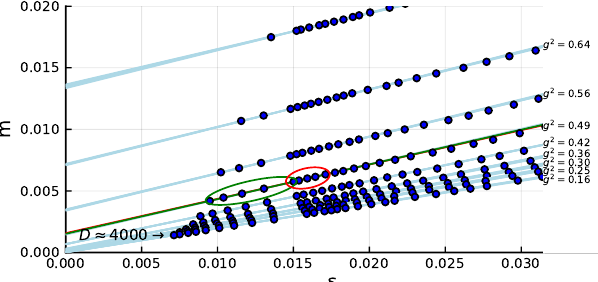
Figure 3 . Extrapolation of the inverse correlation length of the mixed transfer matrix (topological sector), corresponding to the mass estimator m K, 3 , as a function of δ , the spacing in the logarithmic spectrum of the transfer matrix [96]. For every value of the coupling g 2 we show a handful of linear extrapolations towards δ = 0 each taking different points into consideration. For example at g 2 = 0 . 56 we have highlighted the 5 points with highest bond dimension and the corresponding extrapolation in green. Another extrapolation where we discarded the 4 points with highest bond dimension is highlighted in red. These extrapolate to slightly different masses which allows us to estimate the error on the extrapolation that is shown in figure